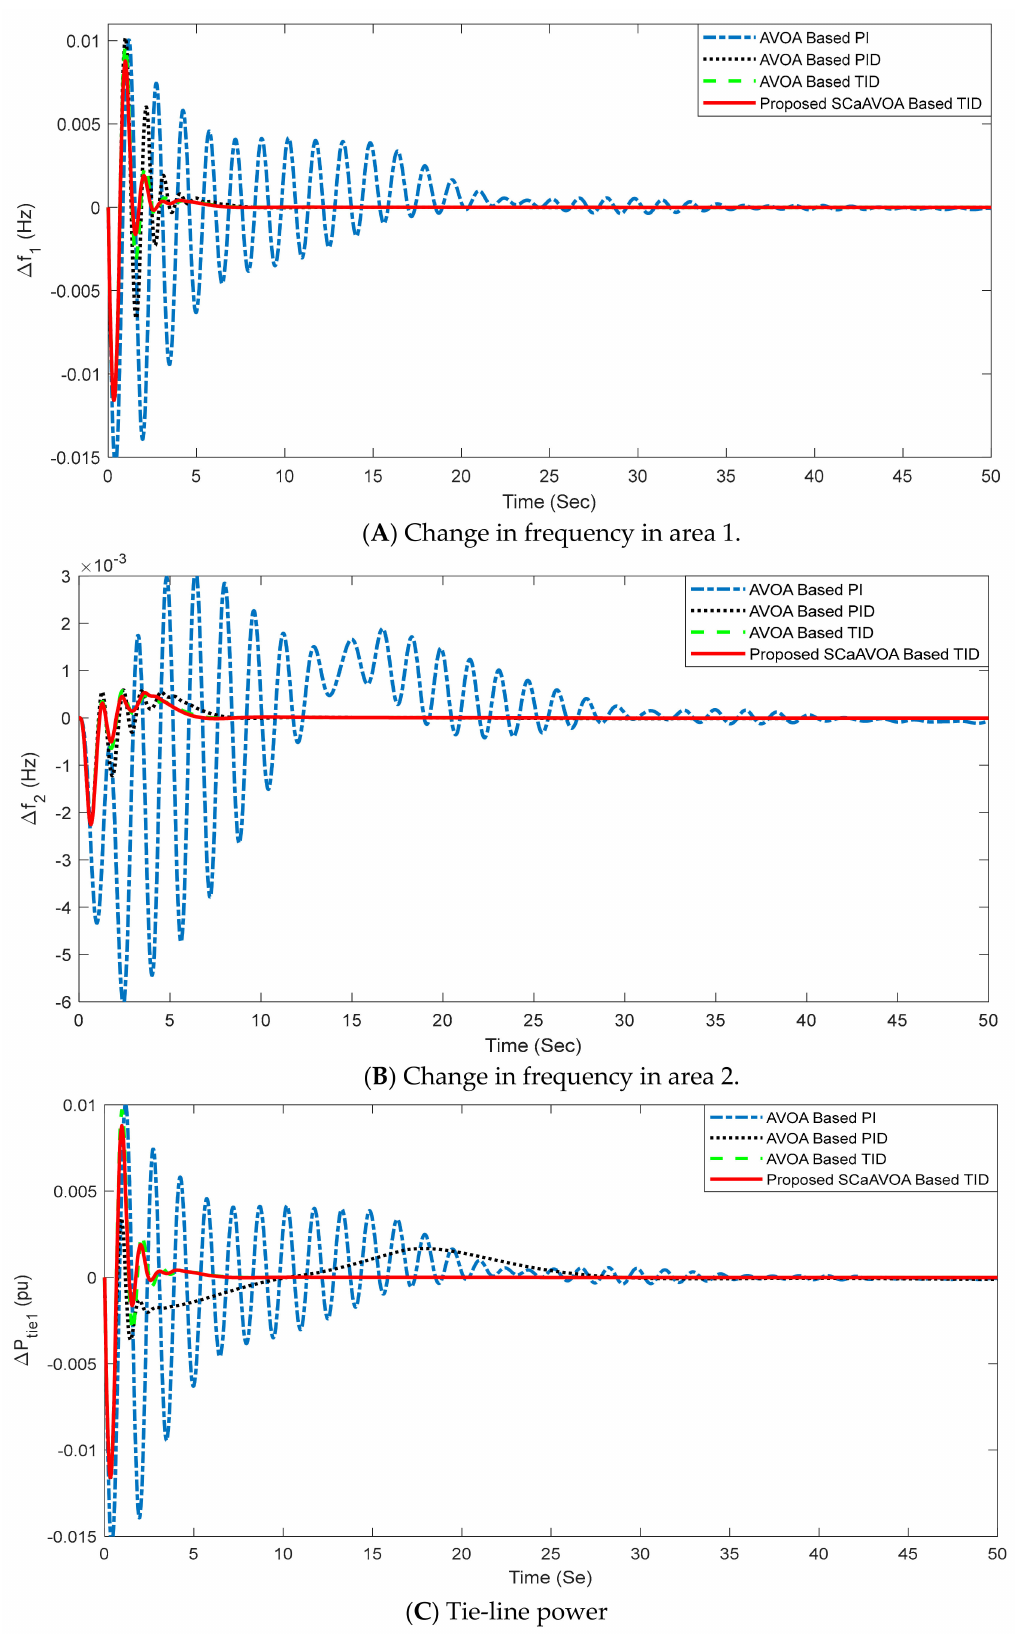
Figure 4. ( A – C ) System response for the five-area power